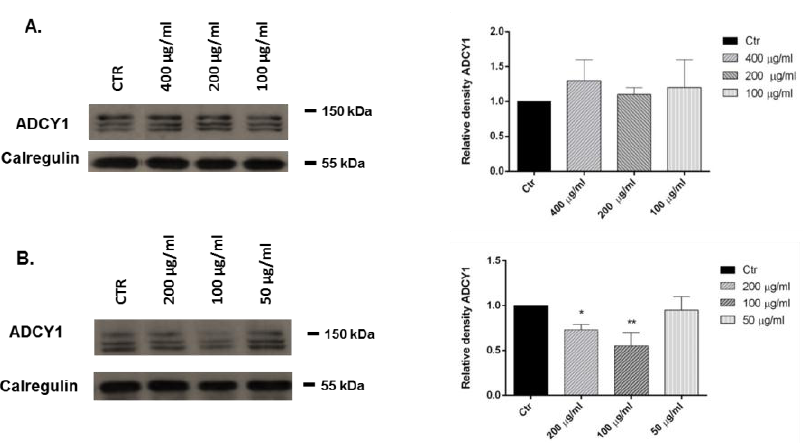
Figure 2. Relative expression levels of the ADCY1 protein in SH-SY5Y cells treated with 1,8-cineole ( A ) and Laurus nobilis essential oil ( B ). Each panel shows the densitometry of bands in the treated groups and control. Values are the mean ± SD in each group ( n = 3). * p < 0.05, compared to control (ANOVA followed by Dunnett’s multiple comparison test).